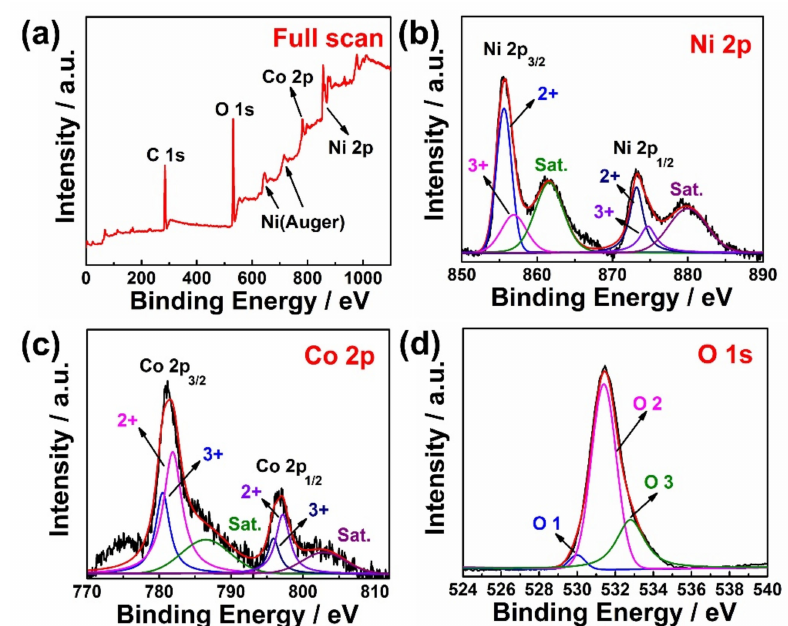
Figure 3. X-ray photoelectron spectroscopy (XPS) spectra of Ni 0.7 Co 0.3 (OH) 2 ( a ) full survey and in the core spectrum region of ( b ) Ni 2p, ( c ) Co 2p, and ( d ) O